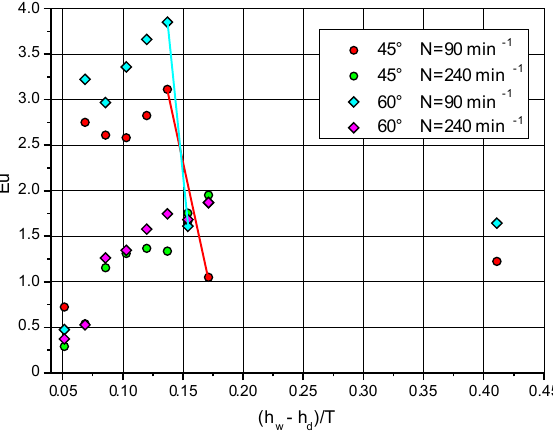
Figure 7. The power number calculated using Equation (1).